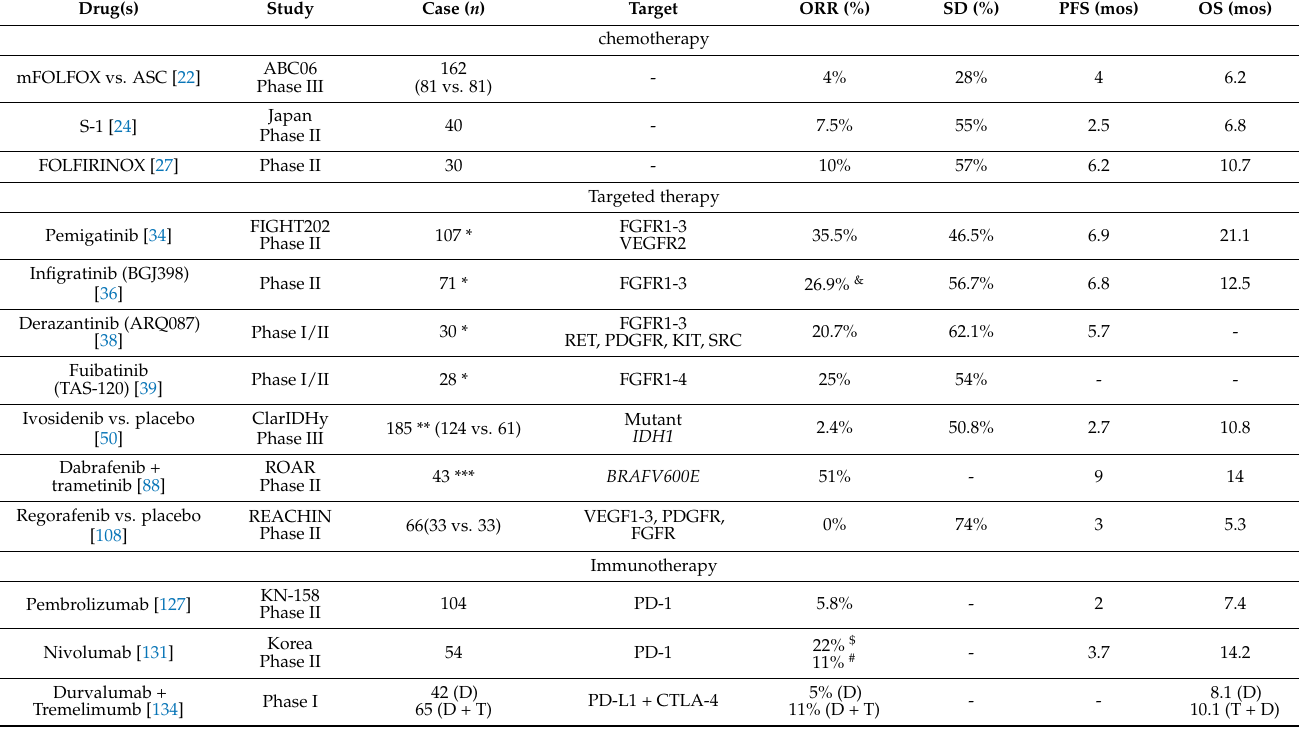
Table 1. Selected representative trials of chemotherapy, targeted therapy and immunotherapy in advanced biliary tract cancer